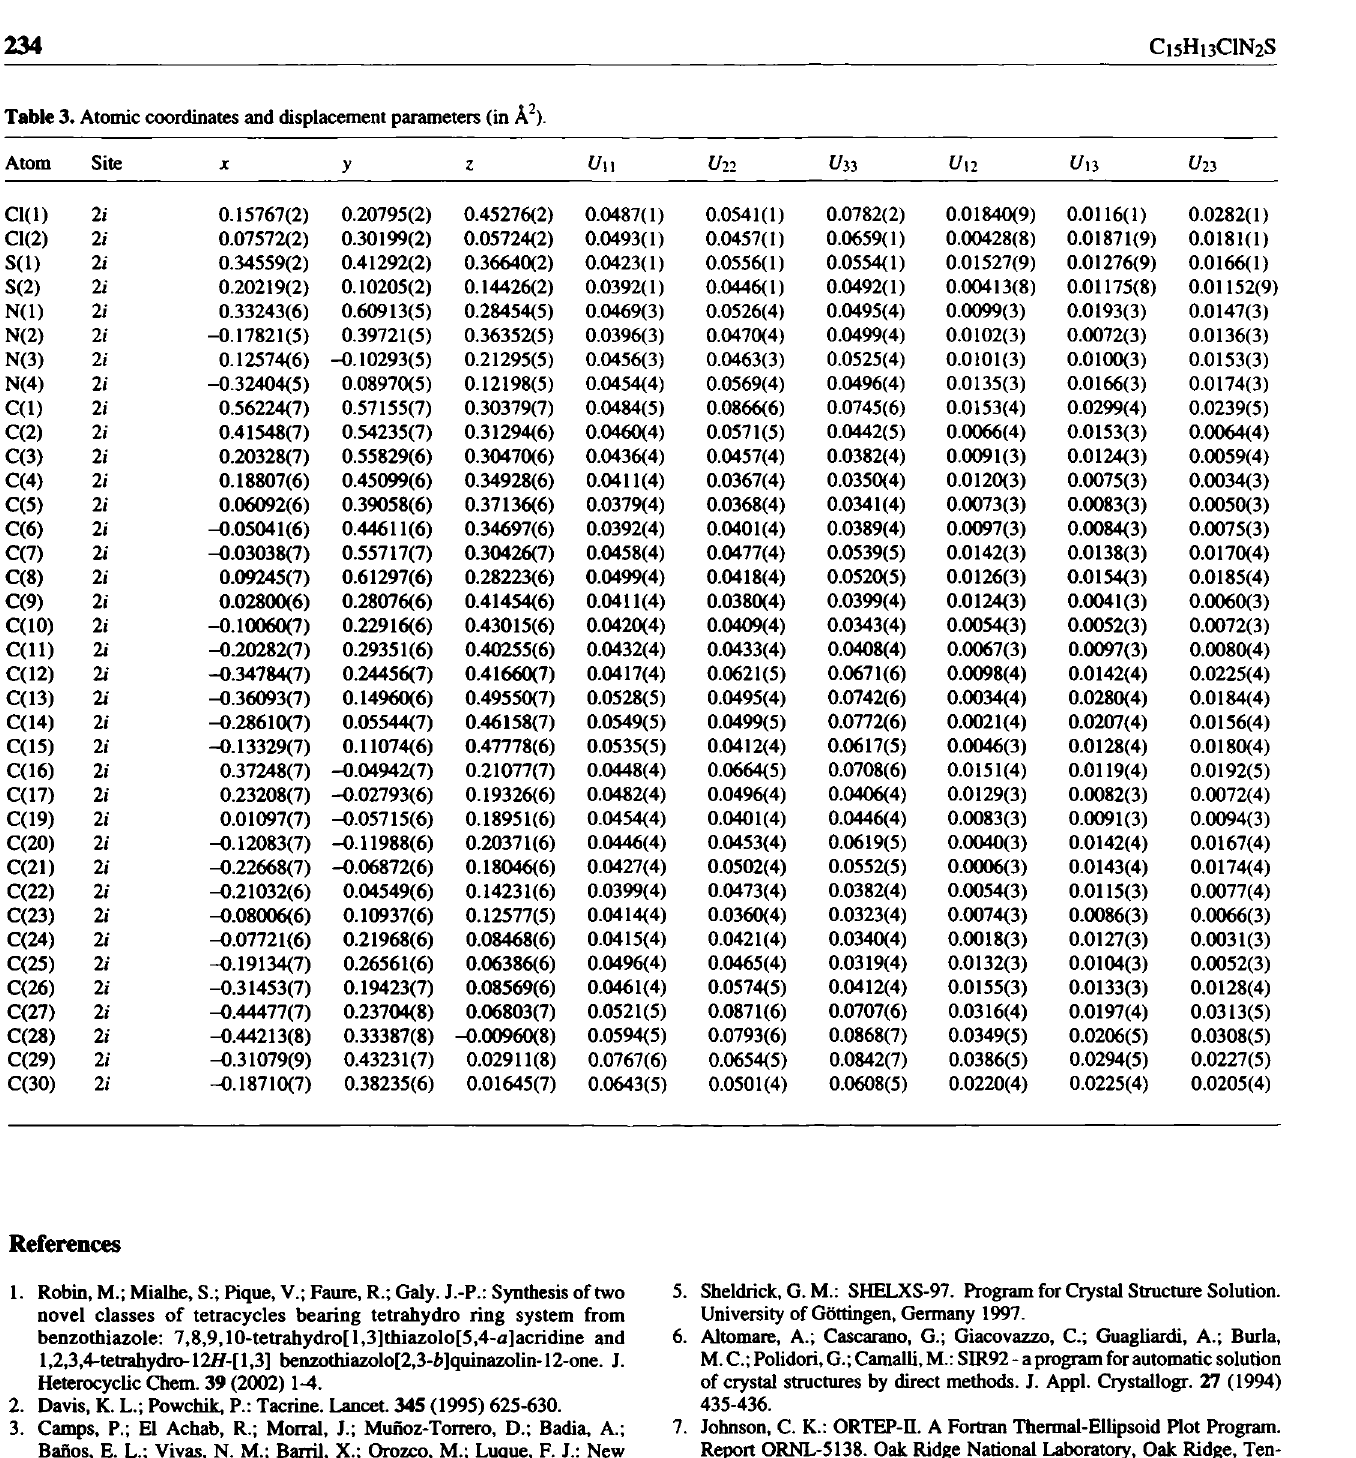
Table 3. Atomic coordinates and displacement parameters (in Â 2